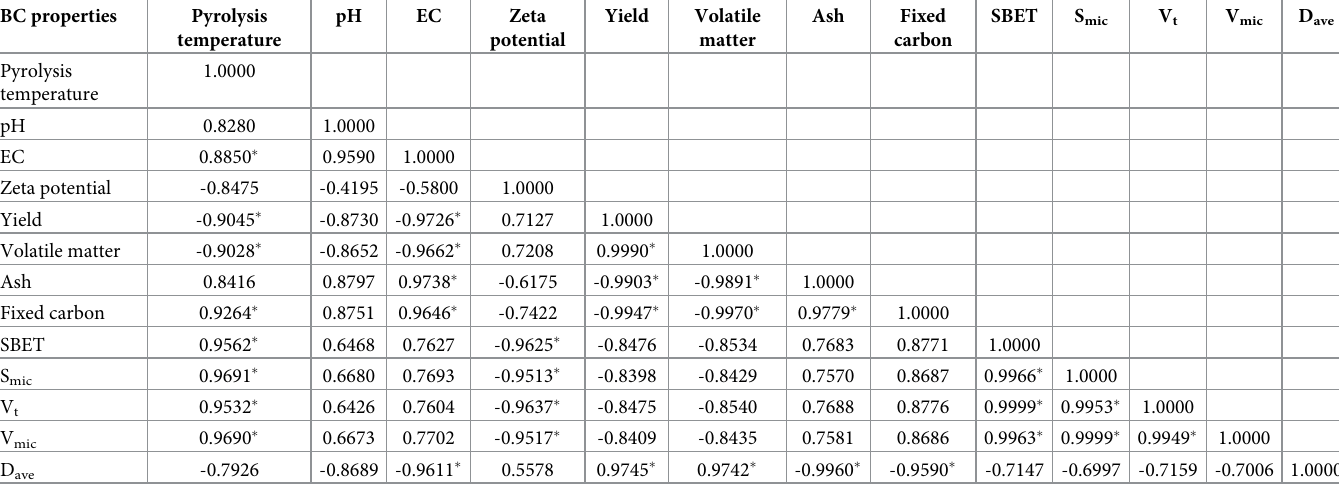
Table 3. Pearson correlation coefficient (r) among Olive Mill Solid Waste-derived Biochar (OMSW-BCs) properties. BC properties